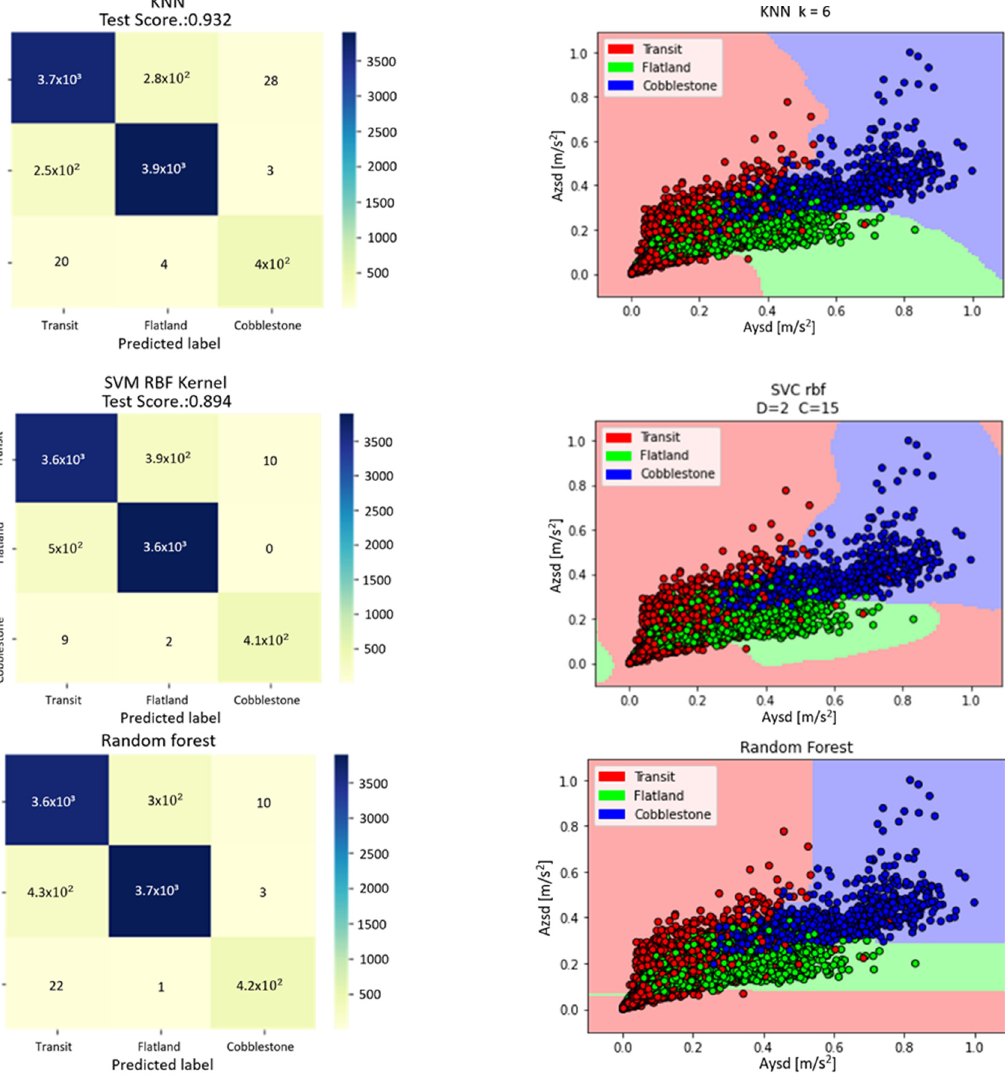
Figure 14. Visualization of the tree data classes in 3-dimensional graphs for 5 different features. 8. Conclusions From the 23 originally proposed features, only some of the mean and standard devi- ation features were found to be important for this work’s classification problem. This does not mean that the RPA and Jerk could not be of use in these kinds of problems, but rather that the particular characteristics of the three driving scenarios that were considered in this work were more easily classified by the other available features. The former affirma- tion can also be applied to the energy features that were not selected in the end. Although the classification result scores of the driving scenarios were high (99%), when analyzing datasets of each pure class (Section 6.1), this was not the objective of the work, and it only served the purpose of providing a baseline of the ideal scenario in which only the pure data of each class were grouped and statistically processed together. After that, the discretization of the data into 2-s samples was closer to the actual purpose of analyzing the driving environment continuously and to make continuous predictions of the current driving environment. In this case, the classification results were over 93.2% and 90.7% accurate for KNN and RF, respectively, while using only eight features to do so. Although the SVM:RBF classifier also achieved high scores (89%), the elevated calcu- lation time to perform predictions and classifications makes it not suitable for real-time applications. It could be used for off-line training and vehicle data analysis, but not di- rectly in real-time decision making. 9. Future Work There is still plenty of research to be conducted to help autonomous driving systems to better perceive and process their environment and trying new approaches will help to bring the next improvements. Some propositions on this matter that can be studied further are: